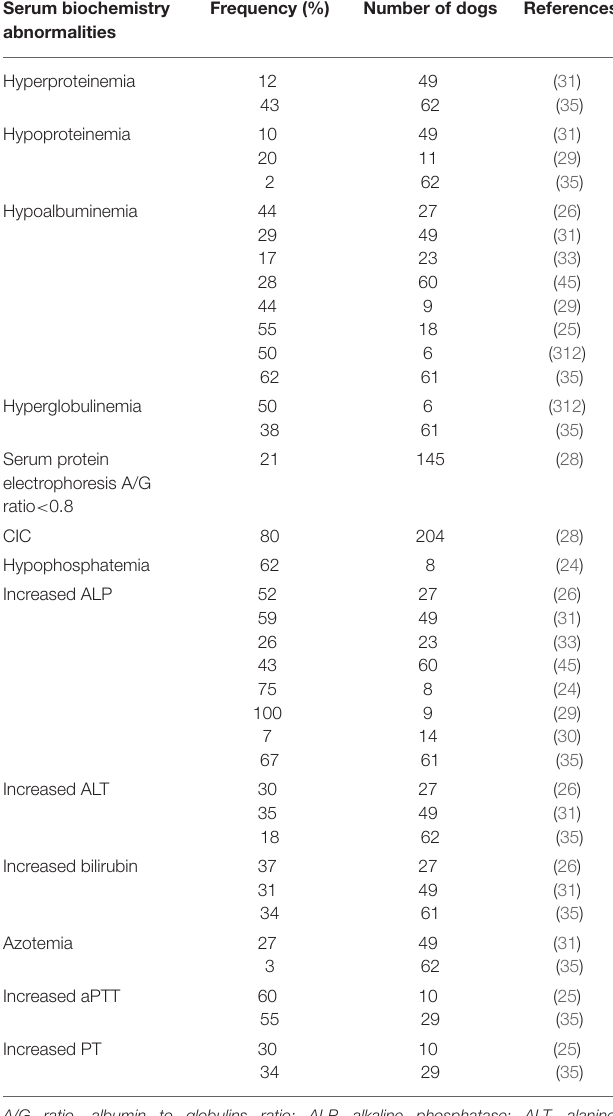
TABLE 4 | Serum biochemistry abormalities associated with canine granulocytic anaplasmosis after natural infection and corresponding frequencies recorded in several studies.